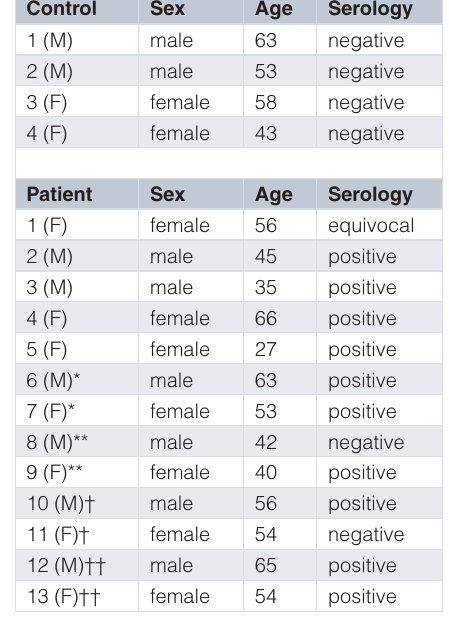
Table 1. Patient Data. Patients 6 & 7 (*), 8 & 9 (**), 10 & 11 (†), and 12 & 13 (††) are sexual